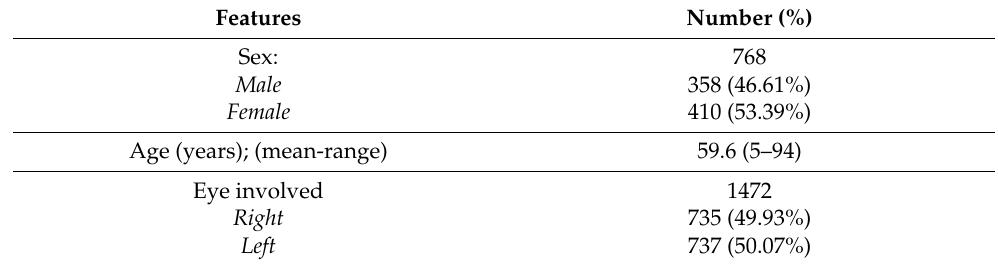
Table 1. Patients’ demographics.